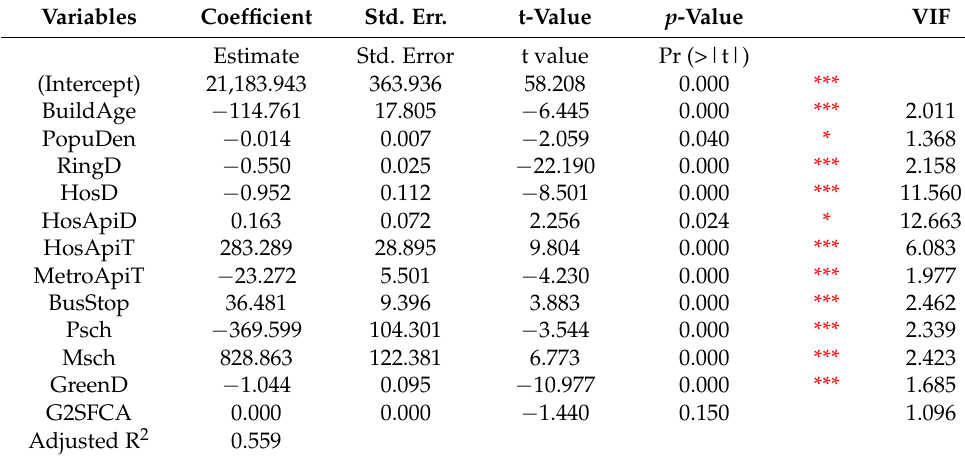
Table 2. Step OLS regression